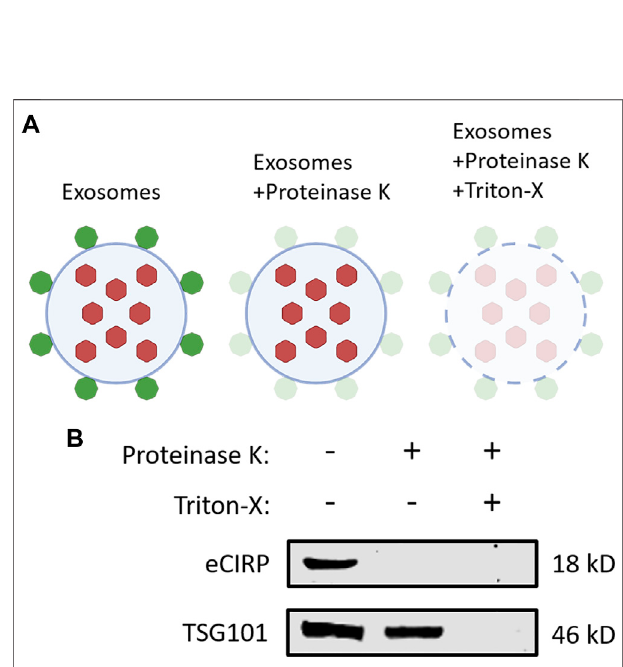
FIGURE 4 | CIRP is present on the surface of exosomes. (A) A schematic diagram of proteinase protection assay. Proteinase K alone only digests the proteins on the surface of exosomes. An additional treatment of Triton-X with proteinase K quenches the proteins both on the surface and inside the exosomes. (B) Exosomes isolated from the supernatants of LPS-treated RAW 264.7 cells were incubated with Proteinase K ± Triton-X at 37 ° C for 30 min and subjected to Western blotting of anti-CIRP Ab and anti-TSG101 Ab. The experiment was repeated three